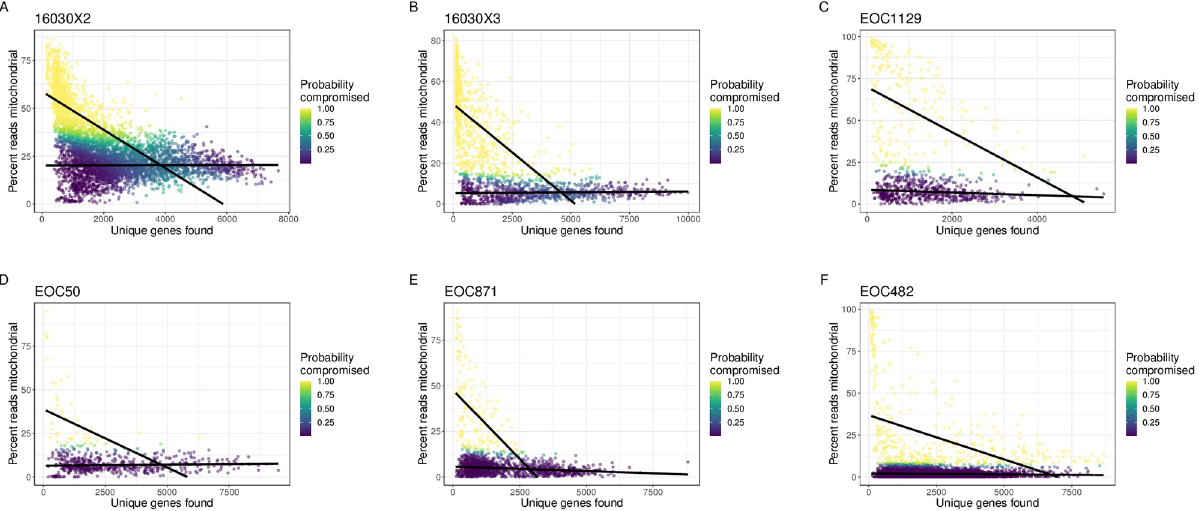
Fig 3. miQC is adaptive across different samples within same cancer type. scRNA-seq data from human high grade serous ovarian cancer (HGSOC) samples from (A-B) the Huntsman Cancer Institute (Sample IDs: 16030X2, 16030X3) and (C-F) the University of Helsinki (Sample IDs: EOC1129, EOC50, EOC871, EOC482). (Data from remaining Huntsman Cancer Institute sample, ID 16030X4, is depicted in Fig 1). We calculated the number of detected genes ( x -axis) and percent of cell counts mapping to mitochondrial (mtDNA) genes ( y -axis) for each cell. Black lines represent the finite mixture of linear regression models estimated from miQC to adaptively identify compromised cells. Color represents the posterior probability of a given cell being a compromised cell (yellow is a high probability and purple is a low probability).